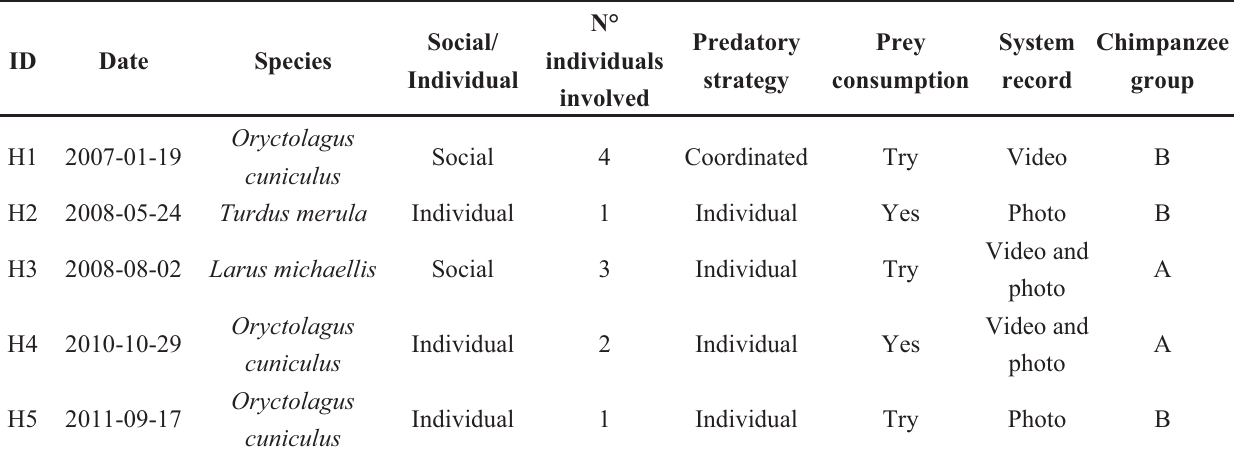
Table 2. Prey captured by FM chimpanzees between 2007 and 2011.